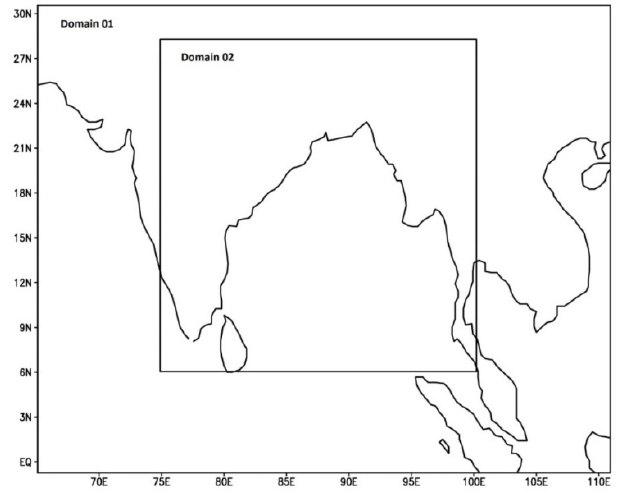
Figure 2. WRF model domains used for experiments of Phailin and horizontal resolutions of D01 (25 km) and D02 (8.333 km, gray-zone grid), respectively.